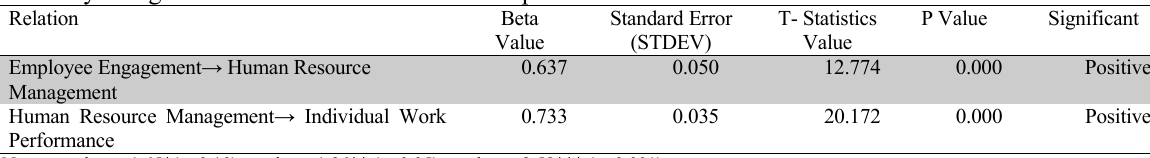
Summary of significance and relevance